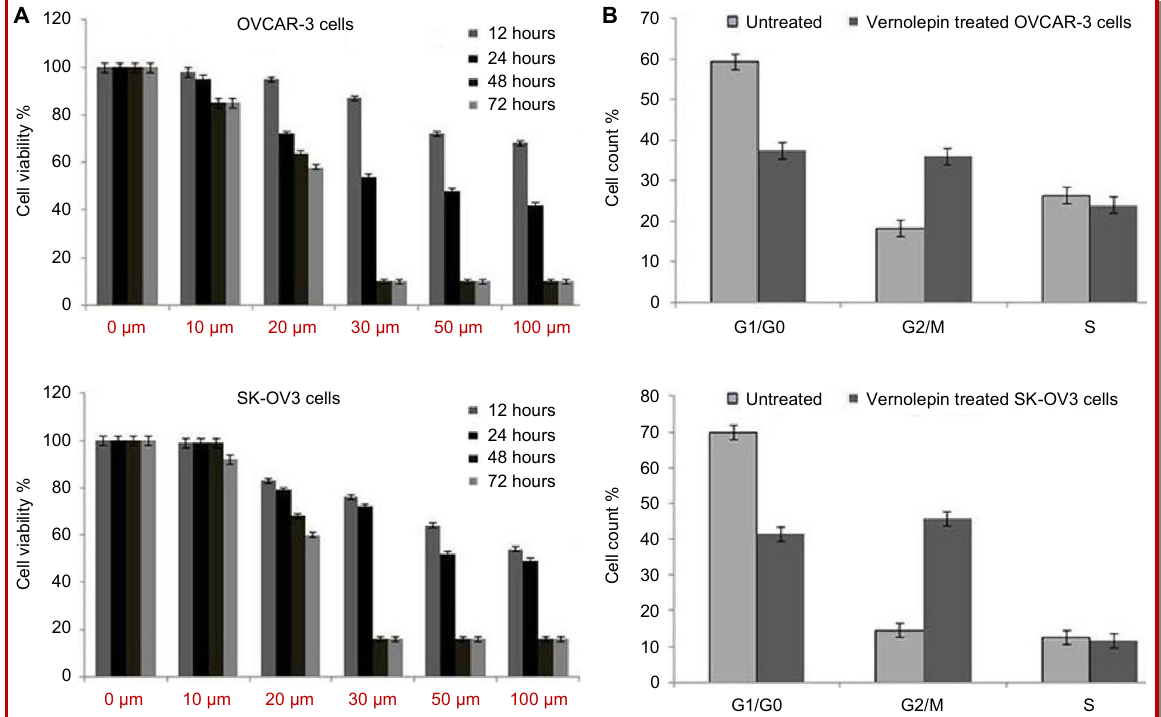
Figure 1 : (A ) Vernolepin inhibited the proliferation of ovarian cancer cells; (B ) Cell cycle was arrested at G2/M phase by vernole- pin. The data are presented as means ± S.D. from three independent